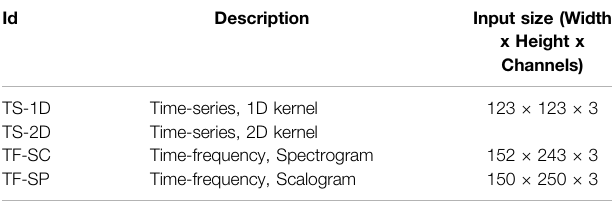
TABLE 2 | Summary of inputs and trained networks.